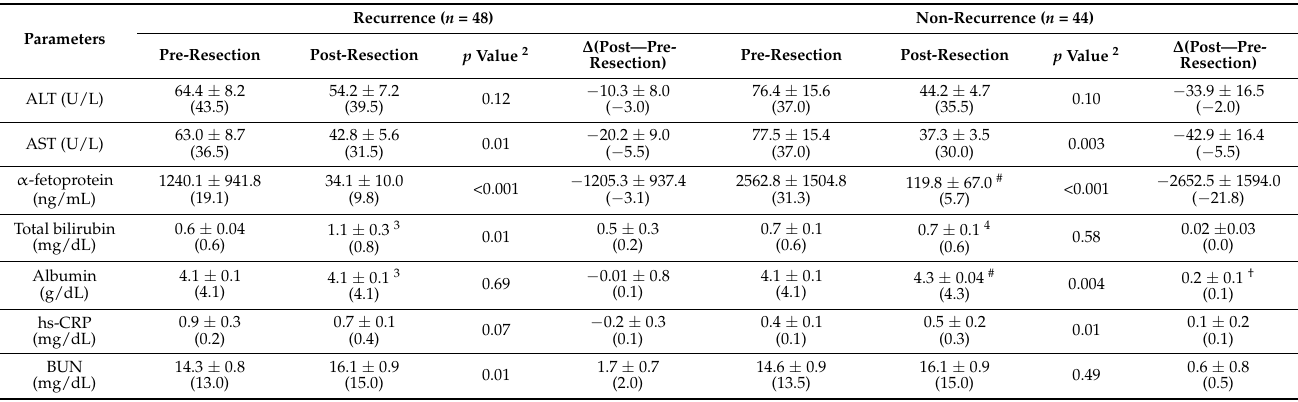
Table 2. Hematological measurements in patients with recurrent and non-recurrent hepatocellular carcinoma at pre-resection and post-resection 1